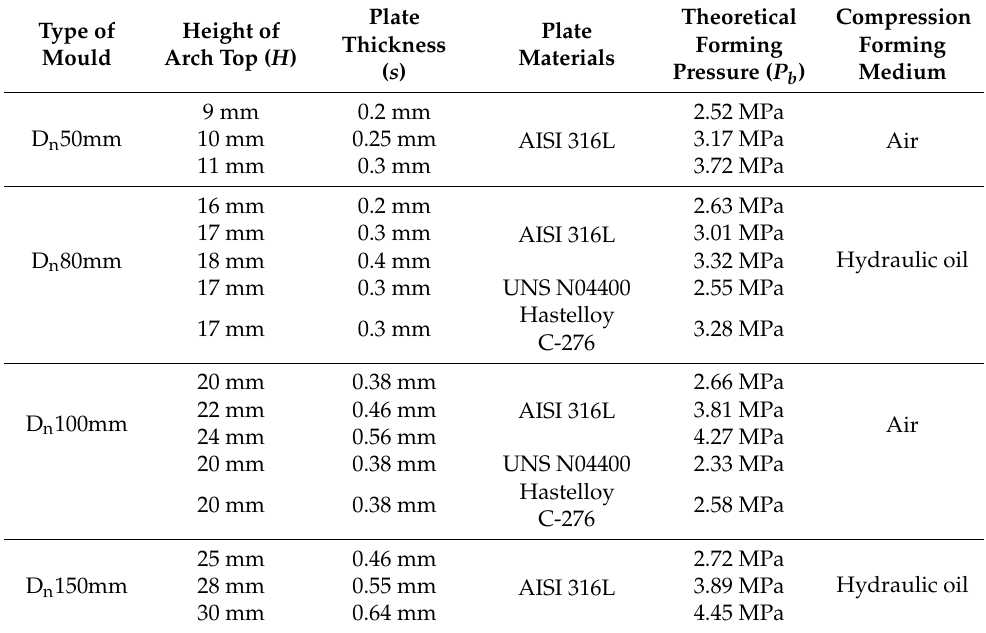
Table 1. Statistics for the modelling parameters and moulding methods of test samples. Type of Height of Mould Arch Top ( H )